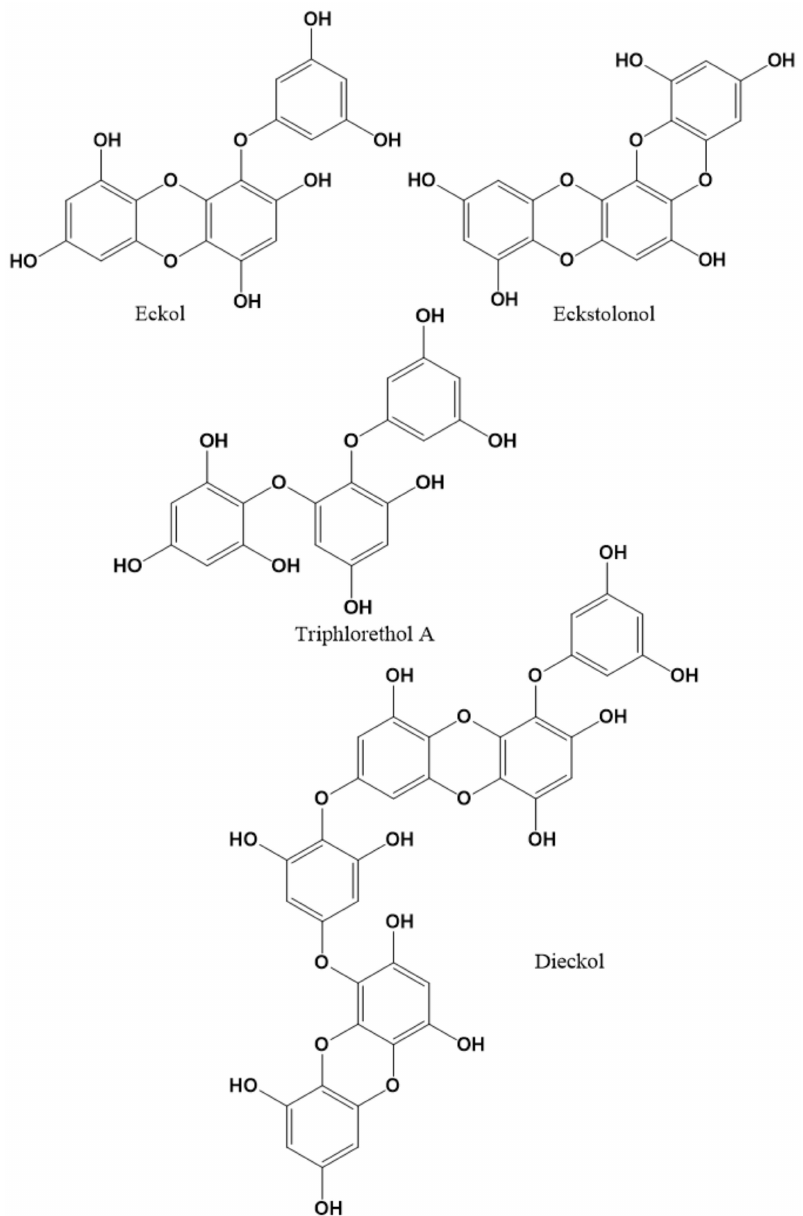
Figure 2. Chemical structures of phlorotannins studied as modulators of the GABA A